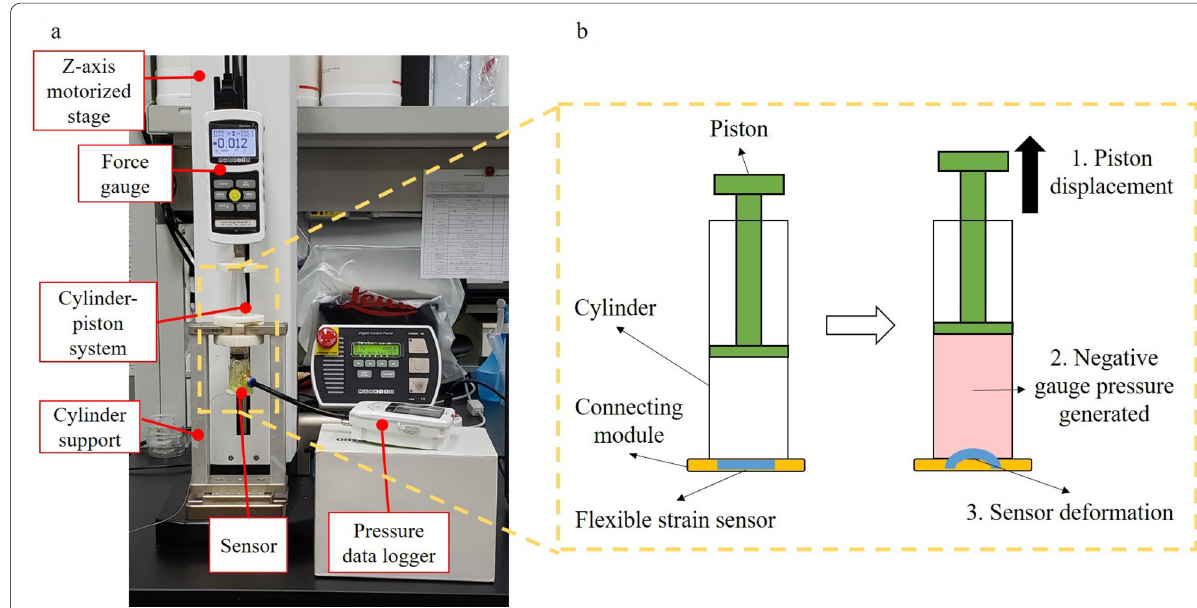
Fig. 3 a Customized evaluation setup to characterize the pressure sensing device and b working principle of the setup to measure the pressure and the change in resistance of the sensor. When the piston is displaced by the Z-axis motorized stage, the negative gauge pressure generated inside the cylinder is measured by a pressure data logger, and the change in resistance of the sensor due to deformation is measured by an LCR